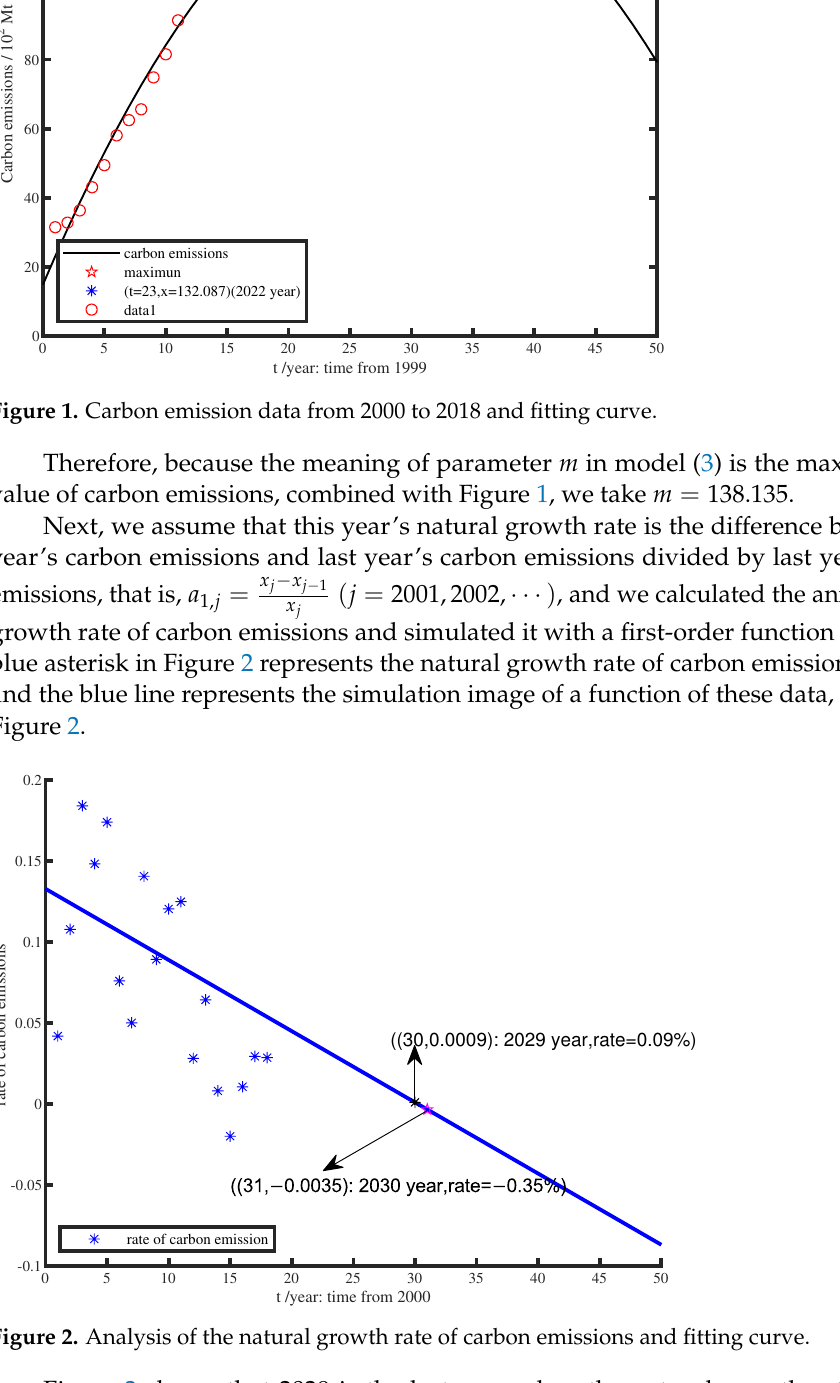
Figure 2. Analysis of the natural growth rate of carbon emissions and fitting